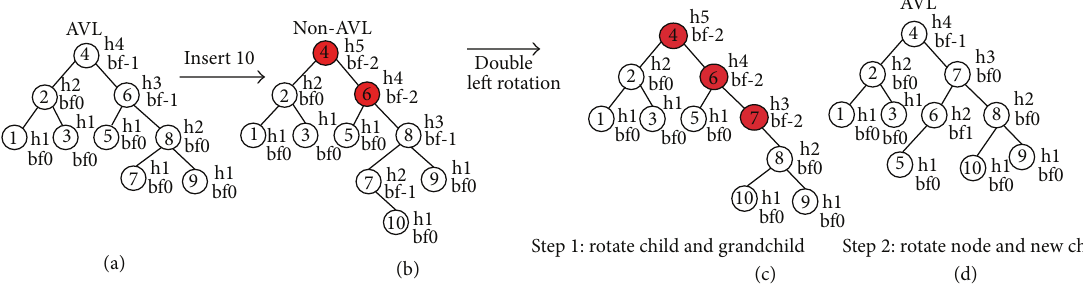
Figure 3: Balancing of AVL tree by double rotation: (a) insertion of new node, (b) non-AVL tree, (c) 1st rotation, and (d) 2nd rotation and balanced AVL tree.